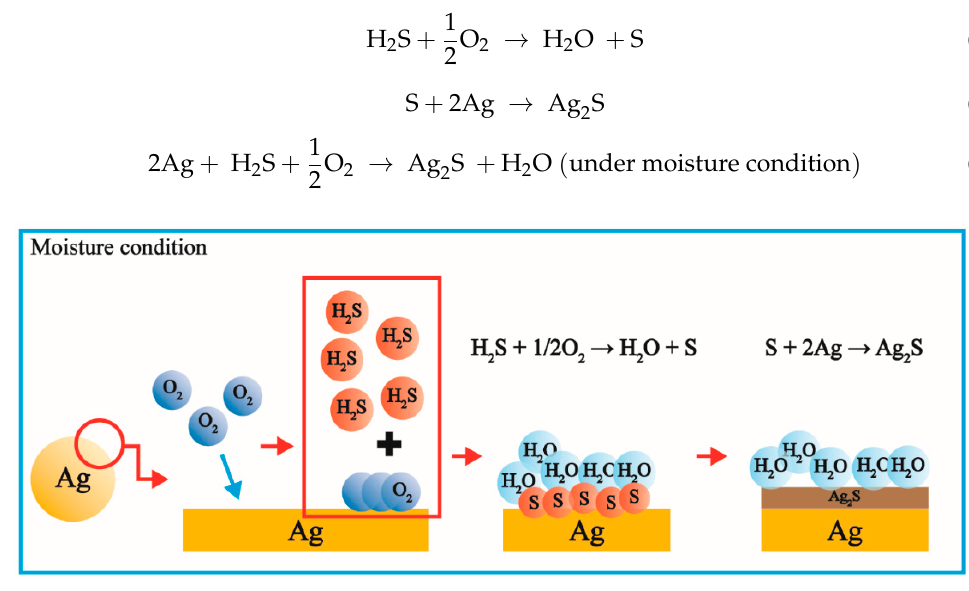
Figure 7. Schematic diagram of sulfidation of AgNP.